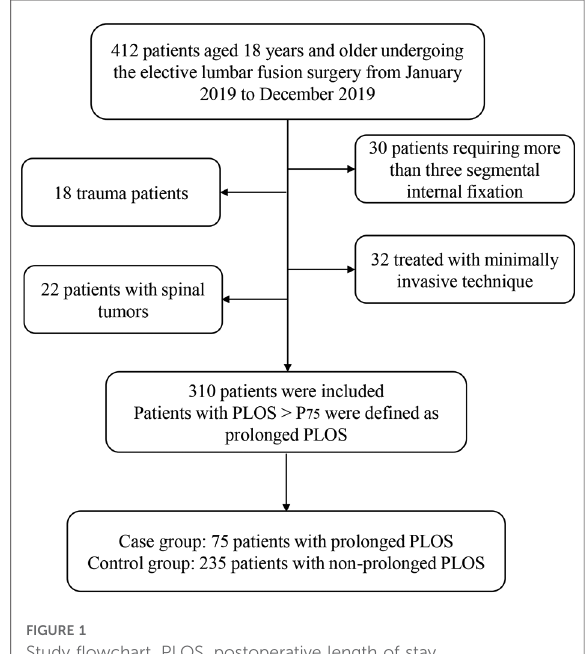
FIGURE 1 Study fl owchart. PLOS, postoperative length of stay.